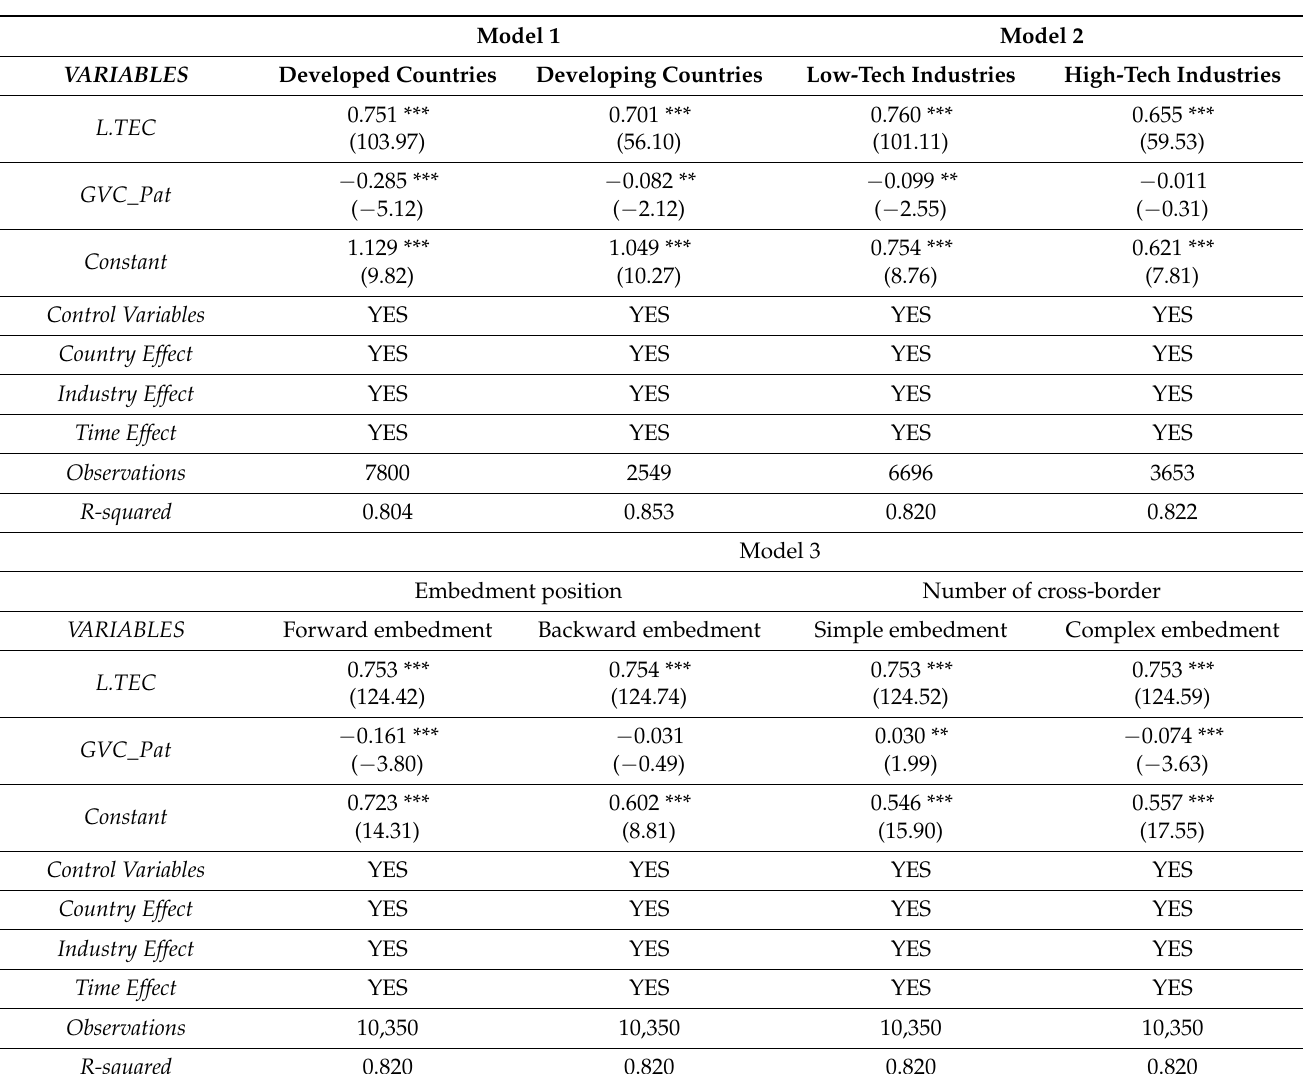
Table 3. Heterogeneity regression